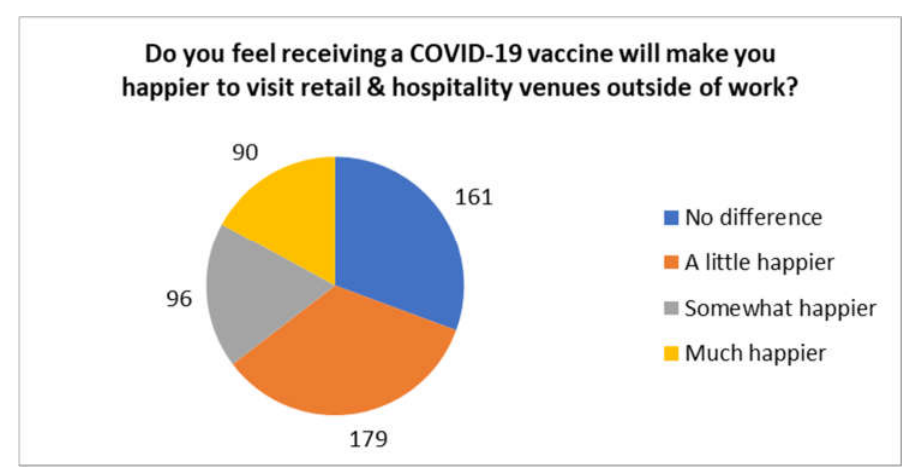
Figure 2. NHS staff perceptions regarding visiting hospitality and retail.